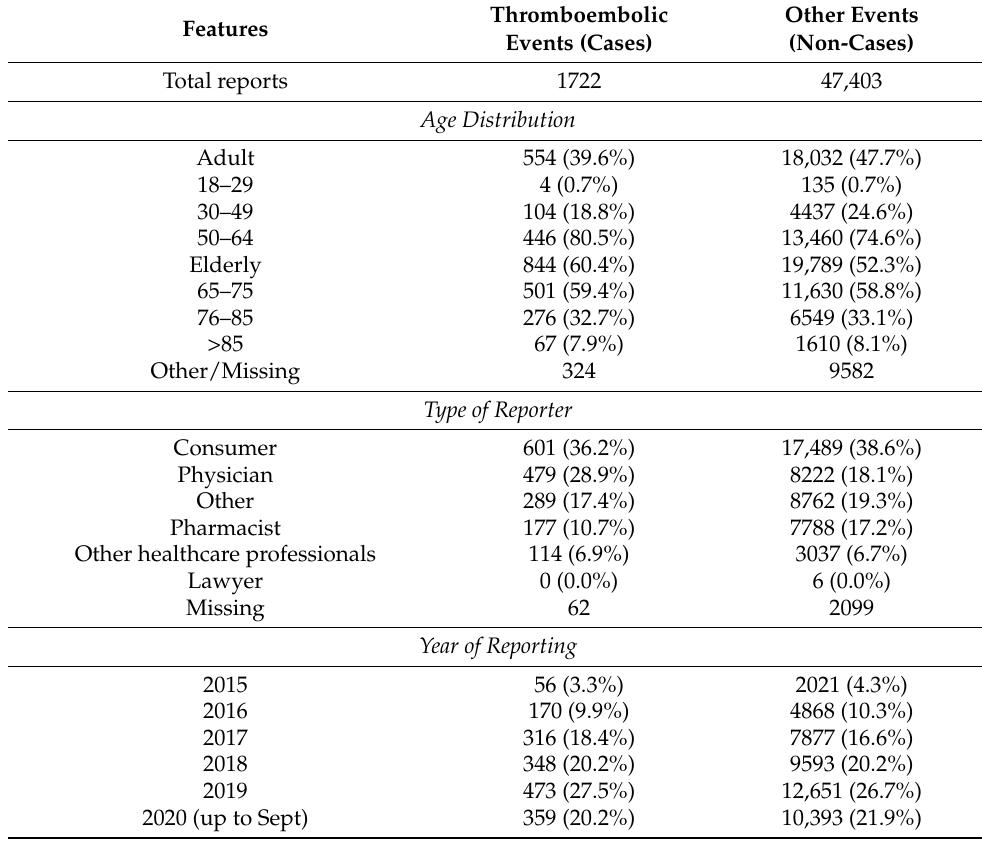
Table 1. Demographic data of CDK4/6